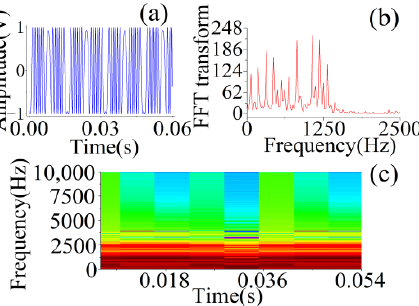
Figure 2. Feature extraction in different aspects of the SMI signal. ( a ) Temporal signal. Sampling rate: 20 kHz, A = 1.05 µ m, f = 62.5 Hz, C = 0.1. ( b ) Spectrogram of the SMI signal. ( c ) SMI STFT analysis plot. Hamming window; window length: 256; overlap points: 128.